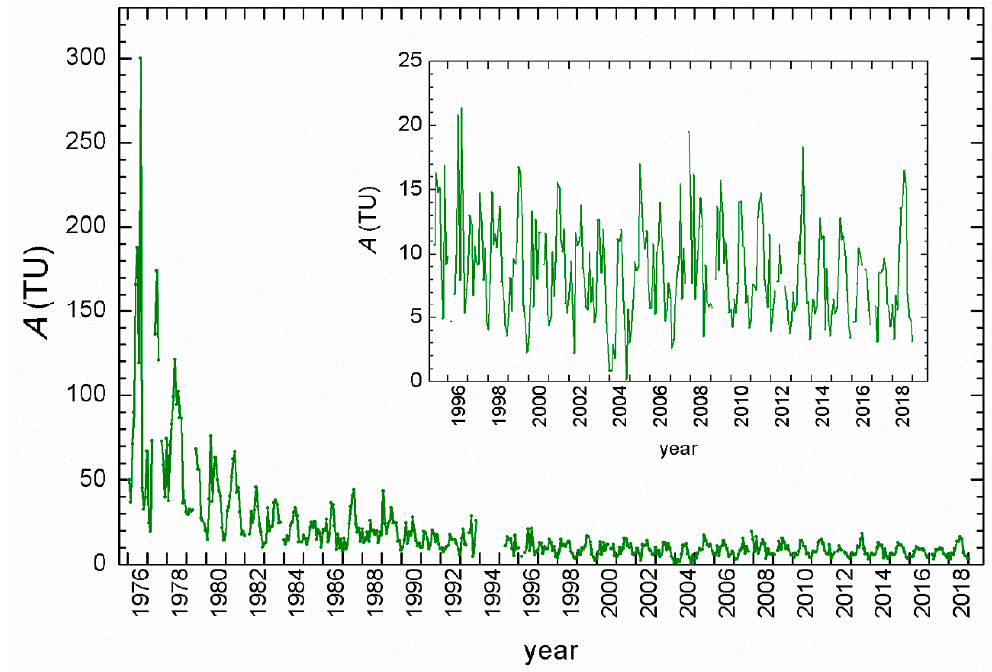
Figure 5. Complete record of monthly tritium activity concentration ( A ) in precipitation at Zagreb, 1976–2018. Insert: for the 1995–2018 period.